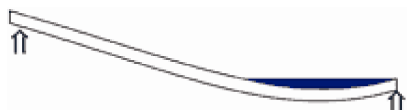
Fig. 5. A scheme showing a reduced slope due to fitting errors (slope 1:80)